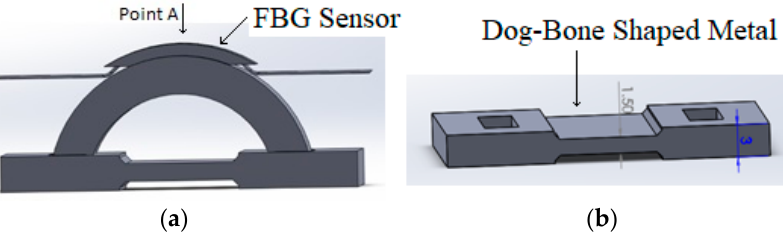
Figure 1. ( a ) External corrosion detection sensor. ( b ) Dog-bone-shaped metal .